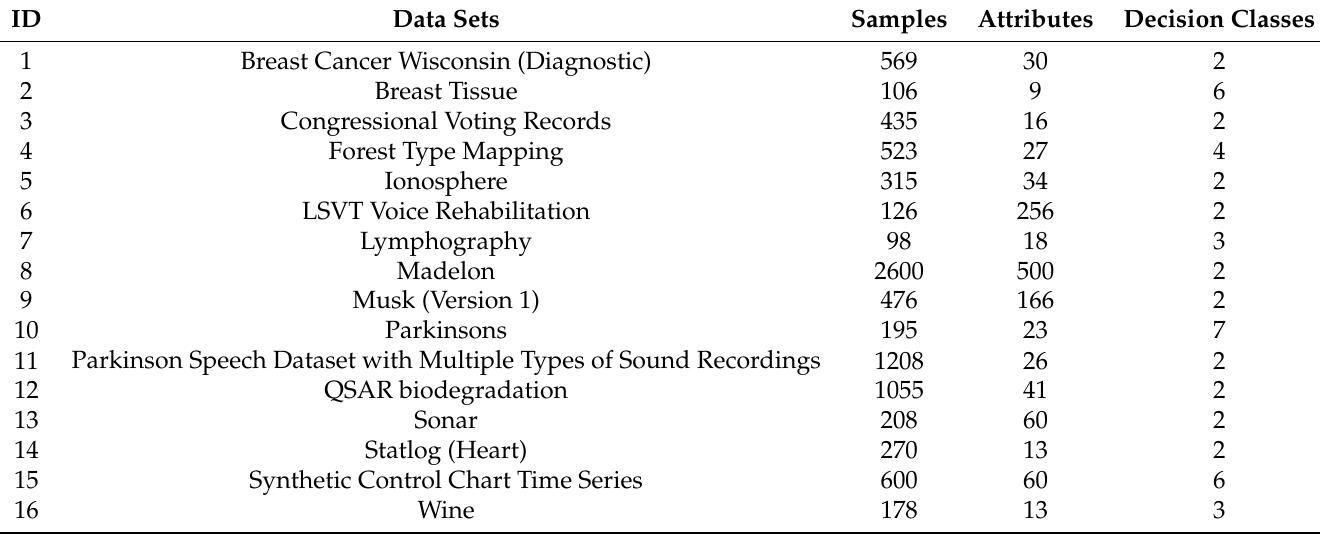
Table 1. Data sets